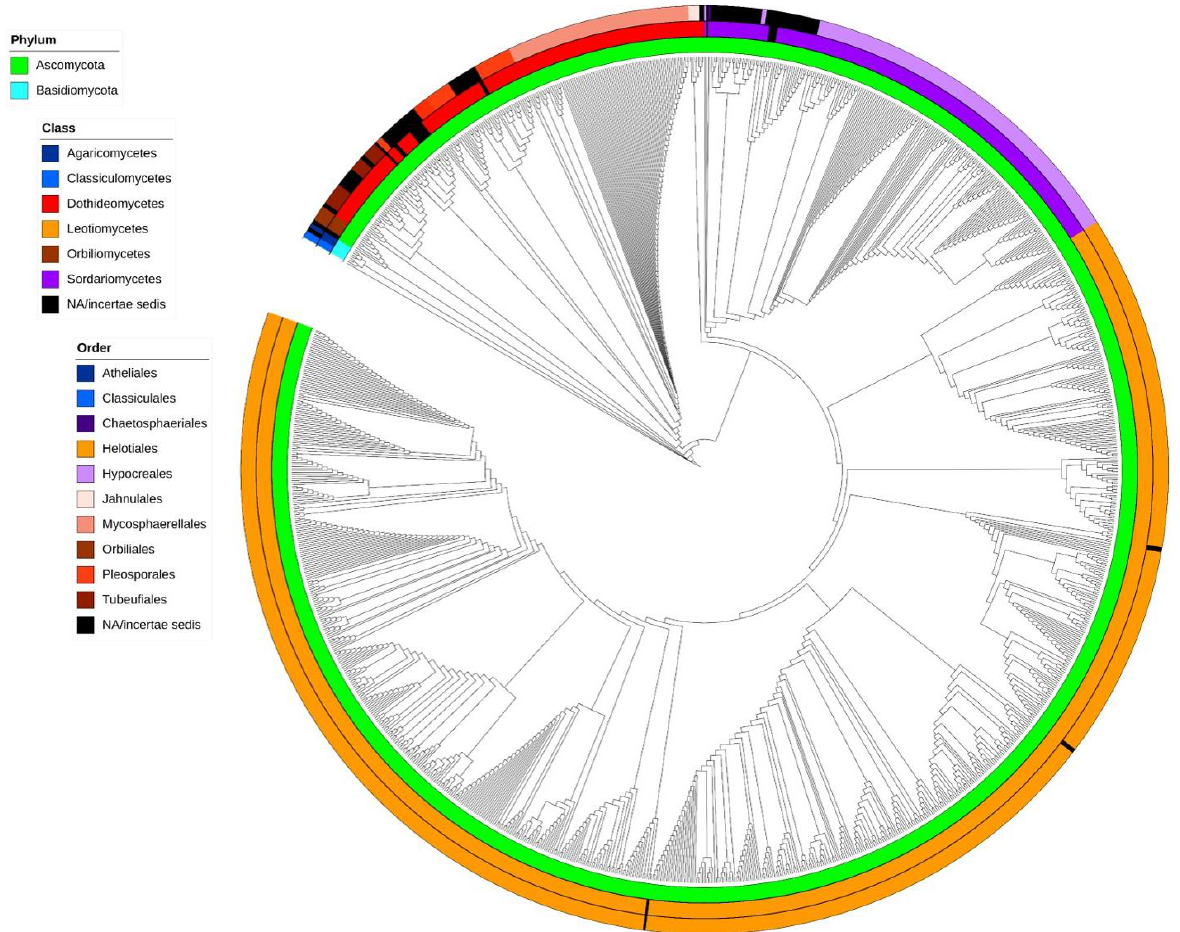
Figure 2. Cladogram showing phylogenetic affinities of aquatic hyphomycetes based on 1252 ITS rDNA barcodes. Circle sections represent taxonomic divisions: inner circle — phyla, middle circle — classes, and outer circle — orders.